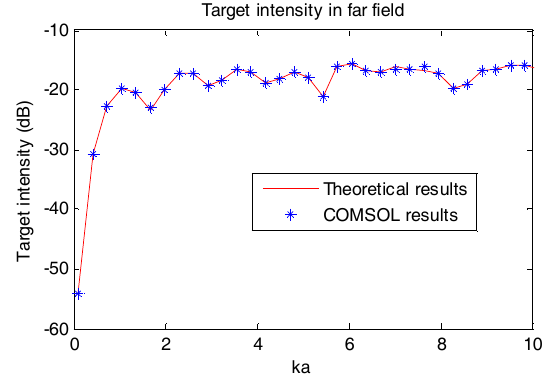
Figure 10. Scattering intensity of the OBS in free field.